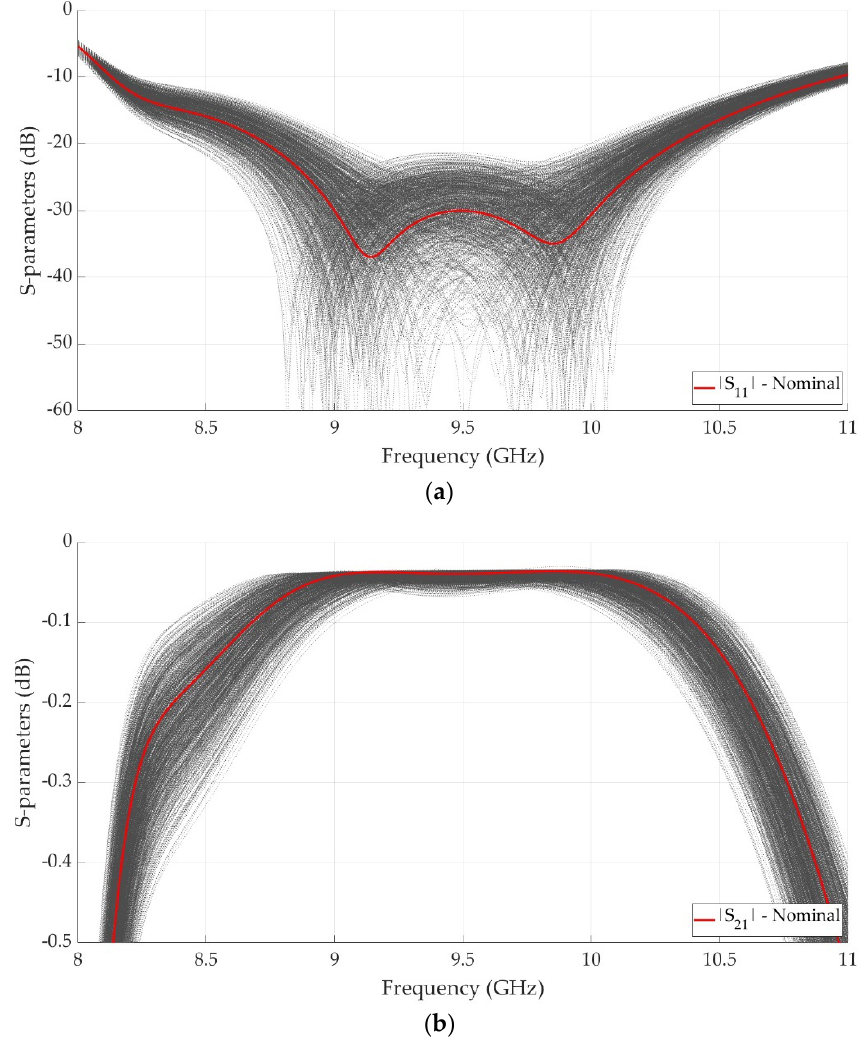
Figure 6. Coaxial-to-GGW IB transition tolerance analysis. ( a ) | S 11 |. ( b ) | S 21 |.